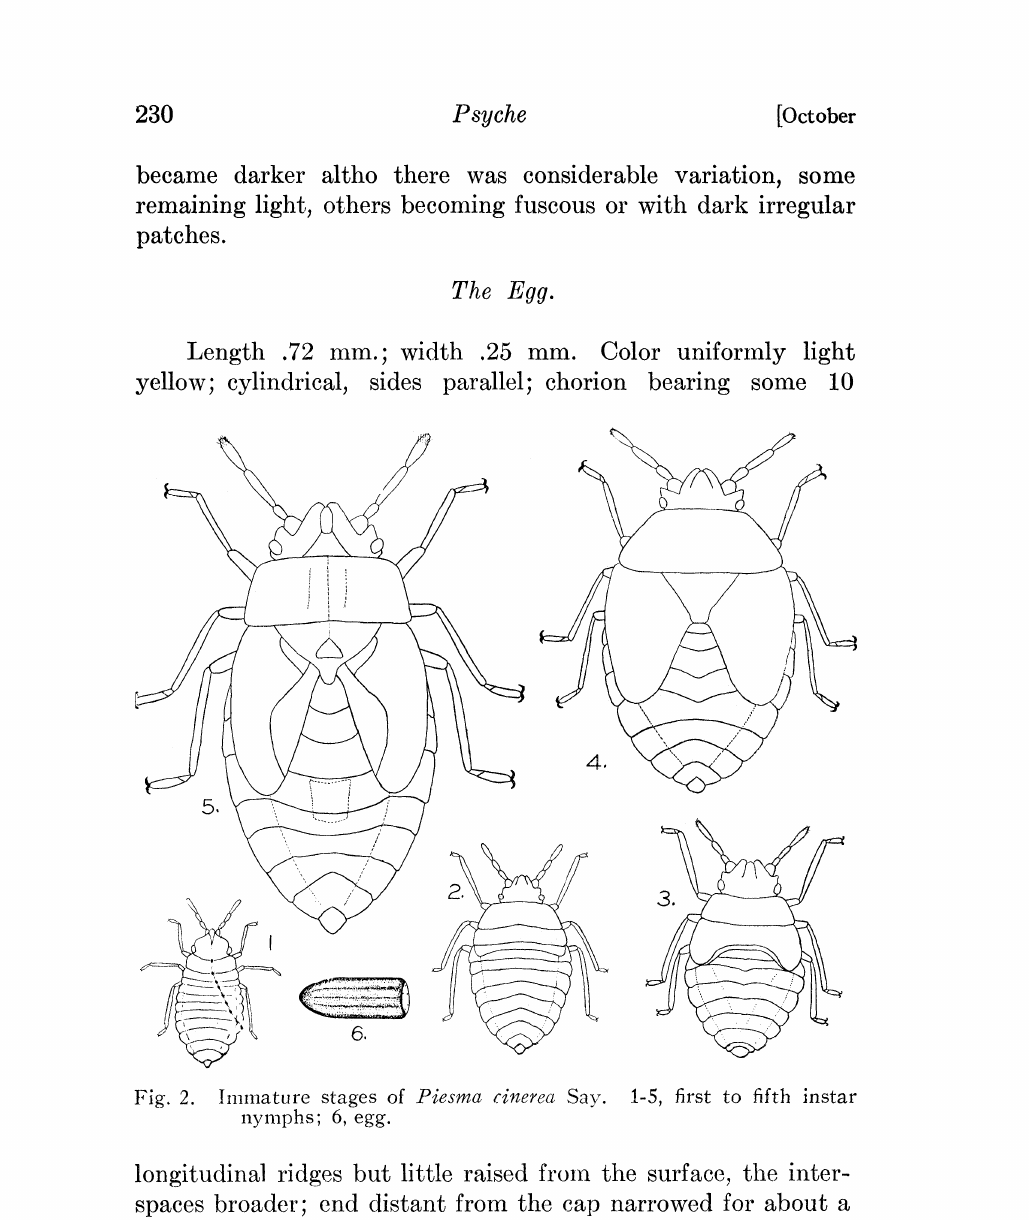
Fig, 2. Immattlre stages of Piesma cinerea Say. 1-5, first to fifth instar nymphs; 6,